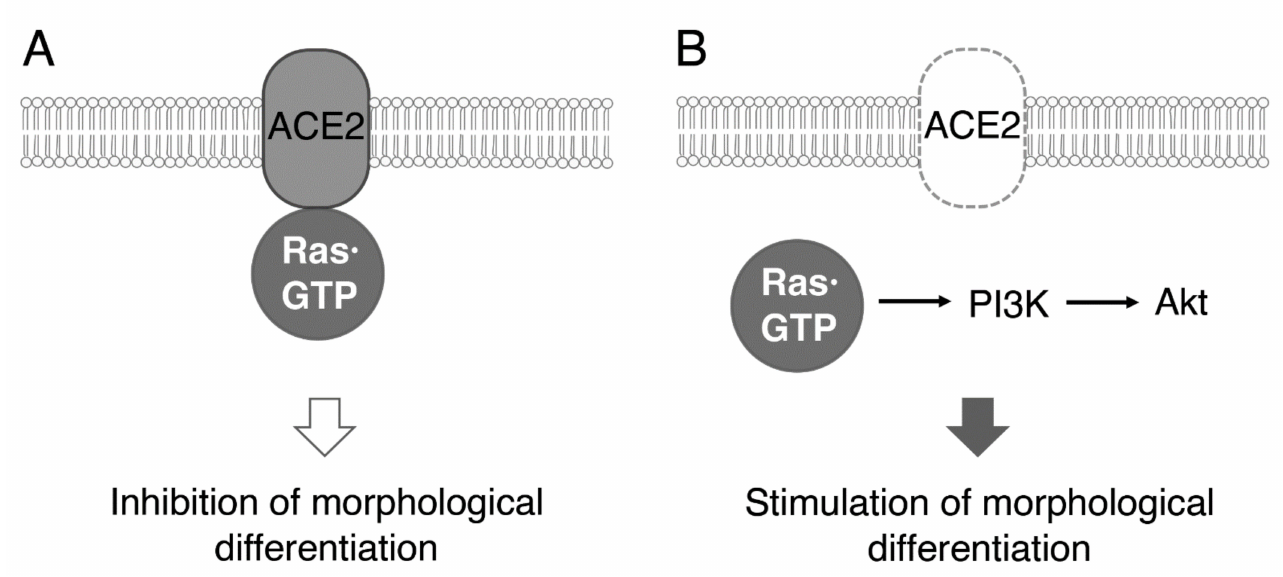
Figure 8. Schematic diagram of the relationship of the ACE2 and Ras signaling with morphological differentiation in FBD-102b cells. ACE2, acting through capturing Ras · GTP, inhibits oligodendroglial cell morphological differentiation ( A ), whereas ACE2 knockdown stimulates morphological differen- tiation through a possible pathway linking to Akt kinase ( B